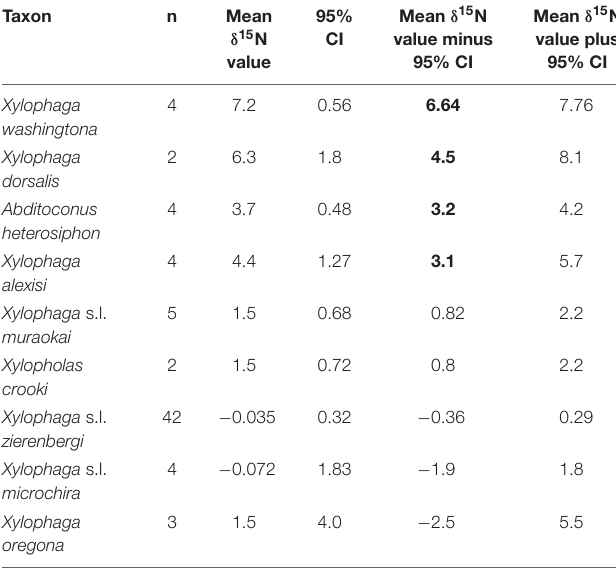
TABLE 2 | Reported are the number of samples, the mean δ 15 N value, 95% confidence interval of the mean (CI) and the lower and upper 95% confidence intervals for each of the nine species represented by more than one specimen treated here; specimens of X . s.l. zierenbergi , X . s.l. muraokai and X . s.l. microchira from two areas were pooled.